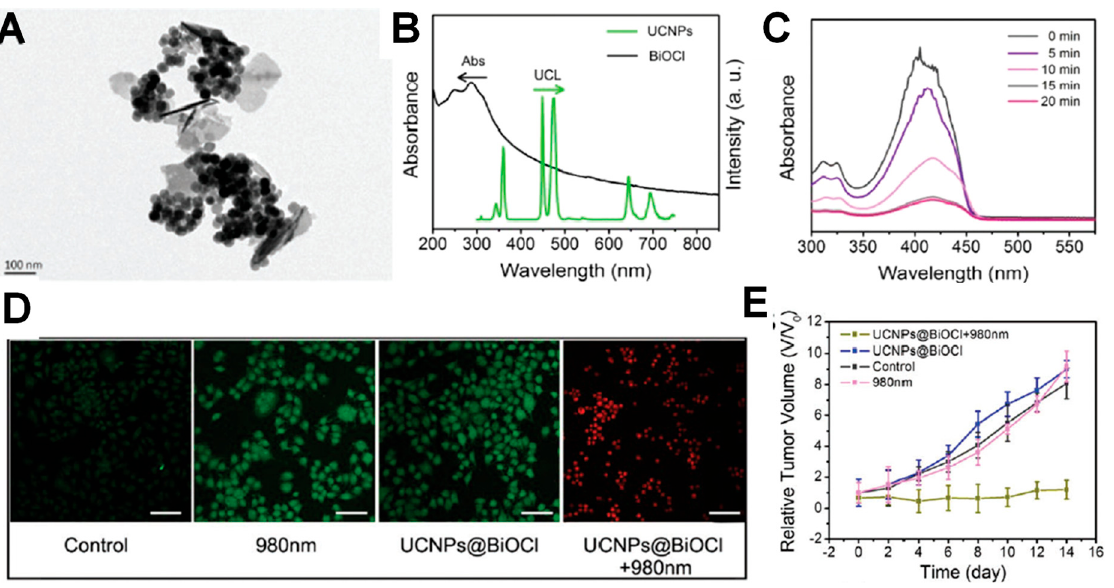
Figure 9. UCNP − BiOCl NMs used for PDT against cancer cells. ( A ) TEM images of UCNP − BiOCl nanosheets; ( B ) the emission spectrum of UCNPs and absorption spectrum of BiOCl nanosheet; ( C ) DPBF absorbance spectrum after treating with UCNP − BiOCl nanosheet with irradiation of 980 nm laser; ( D ) Dead/live staining of cells treated with UCNP − BiOCl NMs; ( E ) Tumor growth curves treated with UCNP − BiOCl NMs. Reproduced with permission from Ref. [ 109]. 2017, Royal Society of Chemistry.